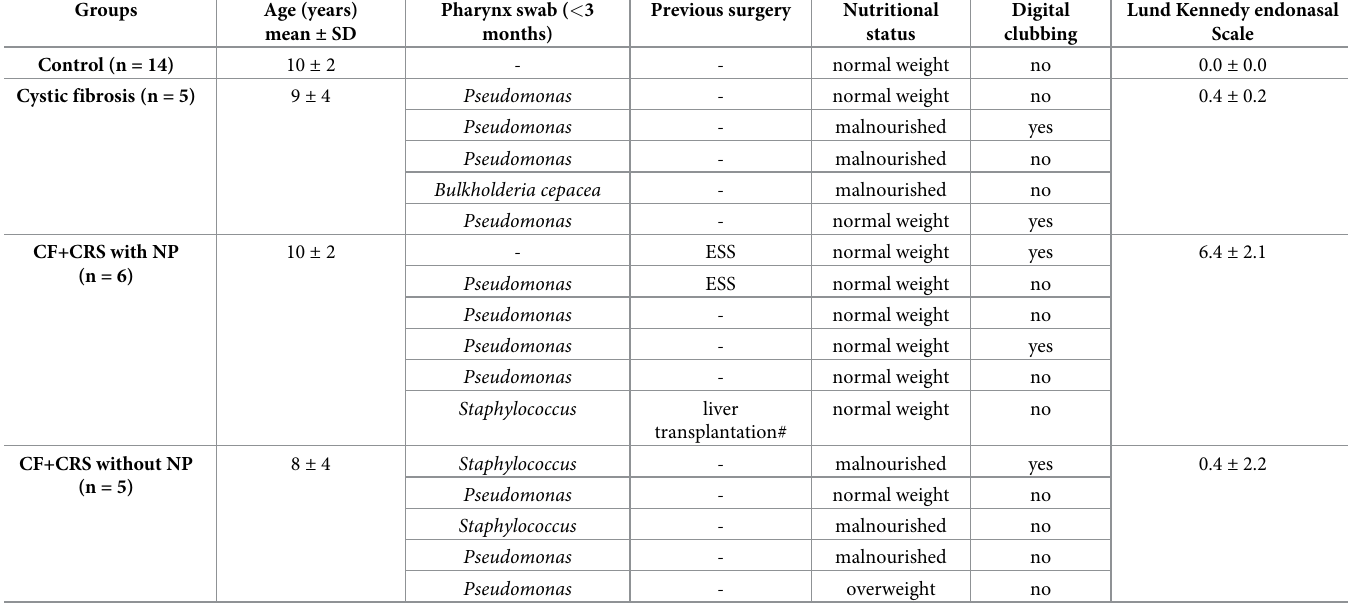
Table 1. Demographics and characterization of study